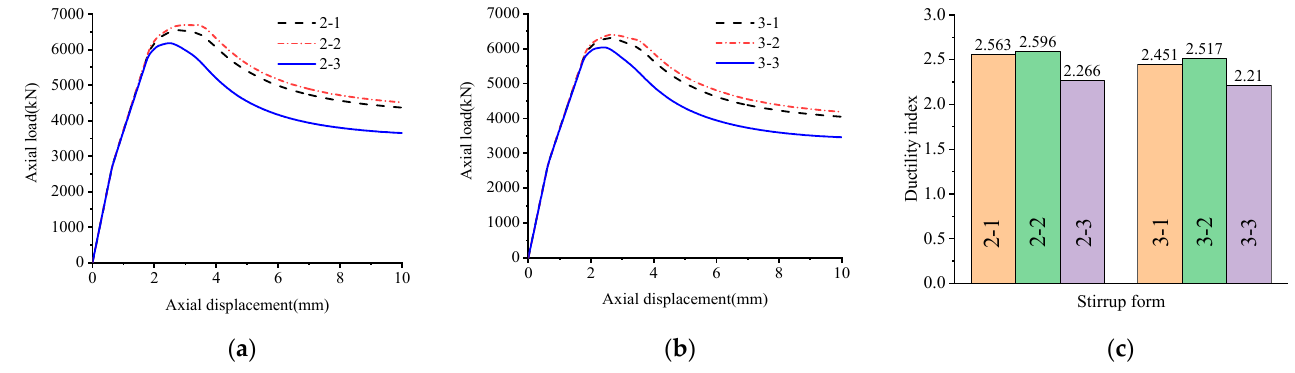
Figure 8. Effect of stirrup constructions: ( a ) Group 2; ( b ) Group 3; ( c ) Ductility index.